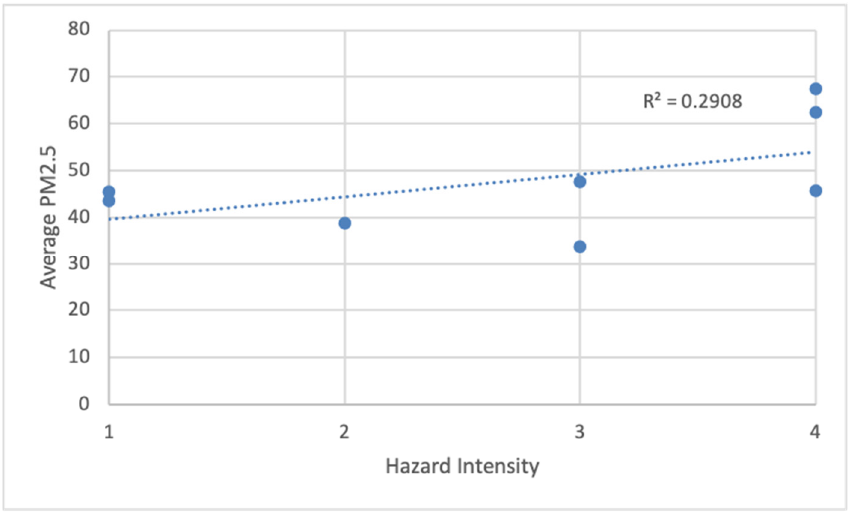
Figure 7. Correlation between average PM 2 . 5 (in µg/m 3 ) and hazard intensity.